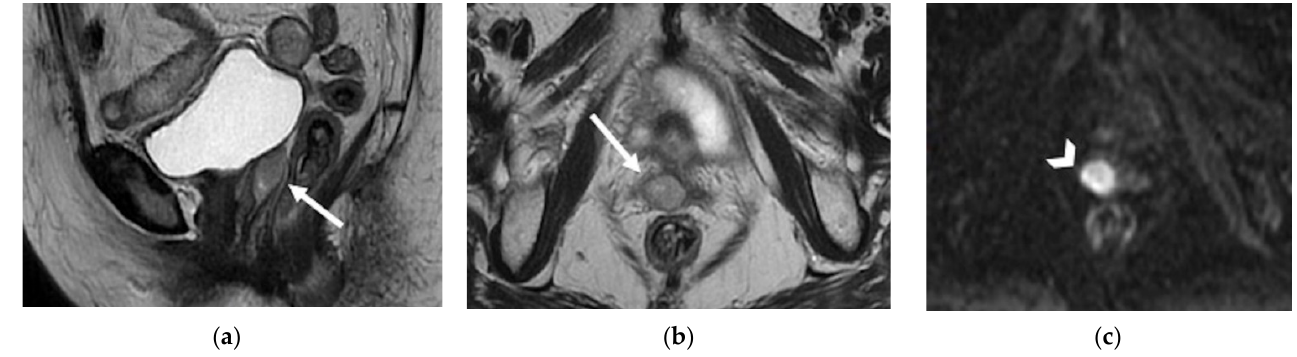
Figure 4. A 57-year-old patient who underwent radical hysterectomy with bilateral salpingo–oophorectomy for cervical cancer. ( a ) Sagittal and ( b ) axial FSE T2-weighted images show a nodular hyperintense lesion in the vaginal cuff (arrows), consistence with relapse. ( c ) Diffusion-weighted image demonstrates highly restricted diffusion of the lesion (arrowhead) in relation to hypercellularity.